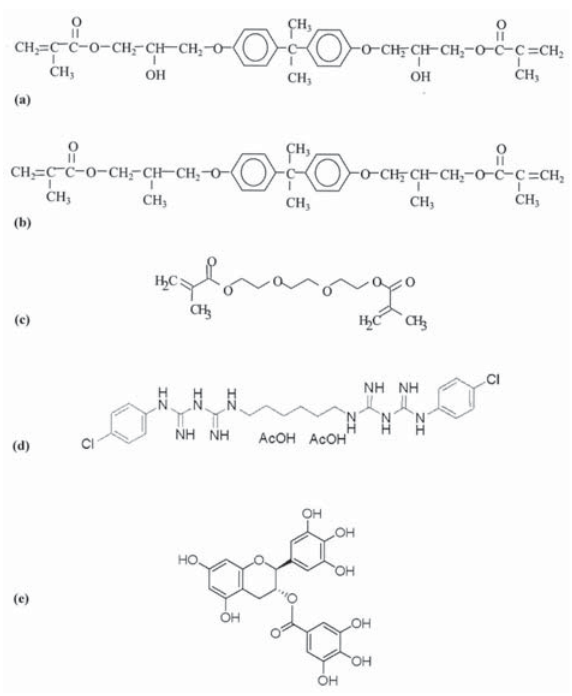
Figure 1- Molecular structure of Bis-GMA (a), CH GMA (b), TEGDMA (c), CHX (d), and EGCg (e)